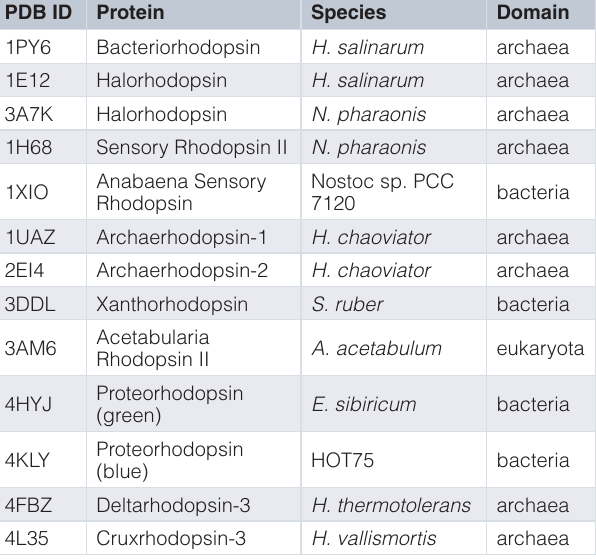
(Figure S3). In the case of GPCRs of various sequences, populations with high scores are dominated by the contribution from intrahelical pairs, whereas interhelical pairs exhibit high scores in the bR sets.